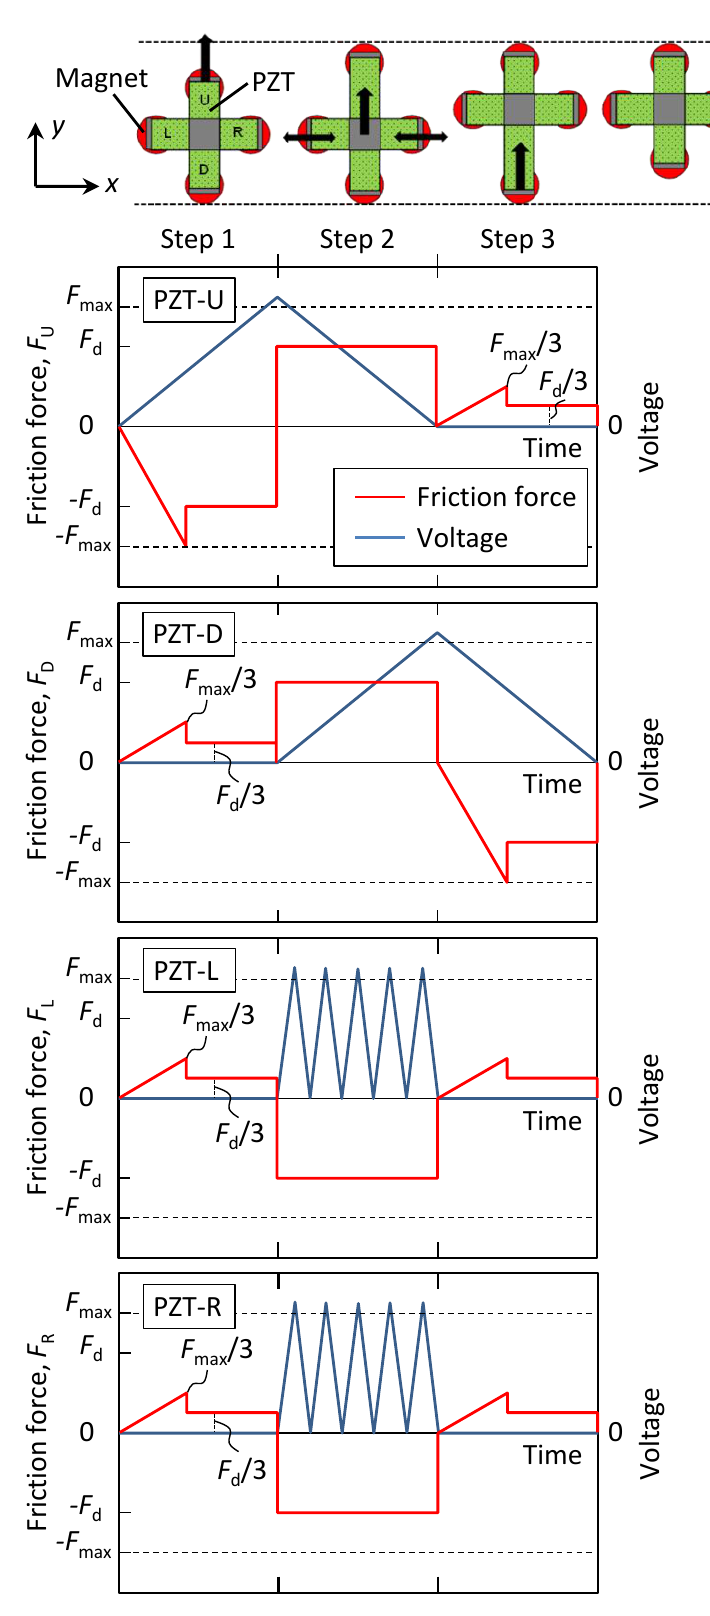
Figure 2. Illustrations of the working principle of the positioner, the voltage patterns applied to the PZT elements and the corresponding frictional forces on the magnetic feet during one cycle of